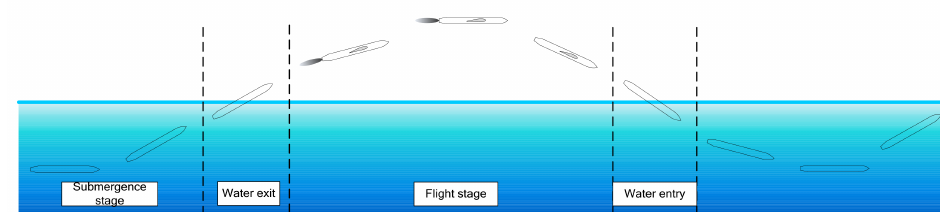
Figure 2. An imagined motion profile of an HAUV.